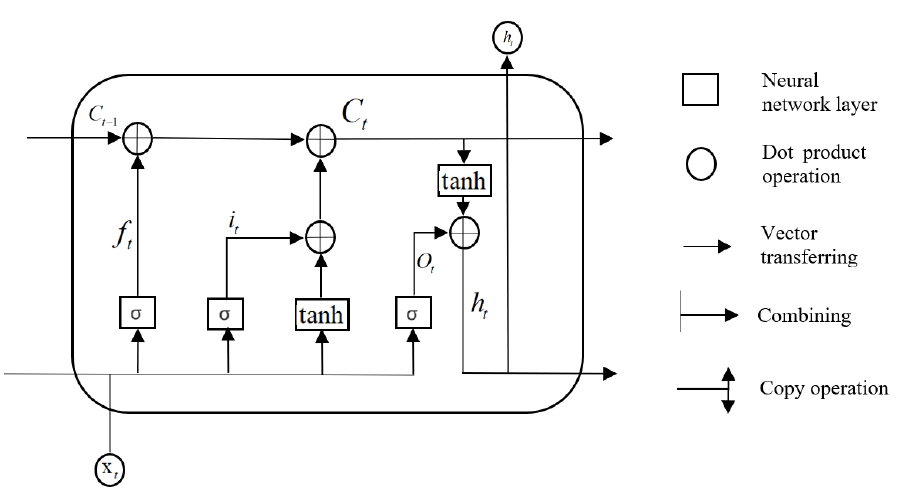
Figure 2. LSTM structure diagram.